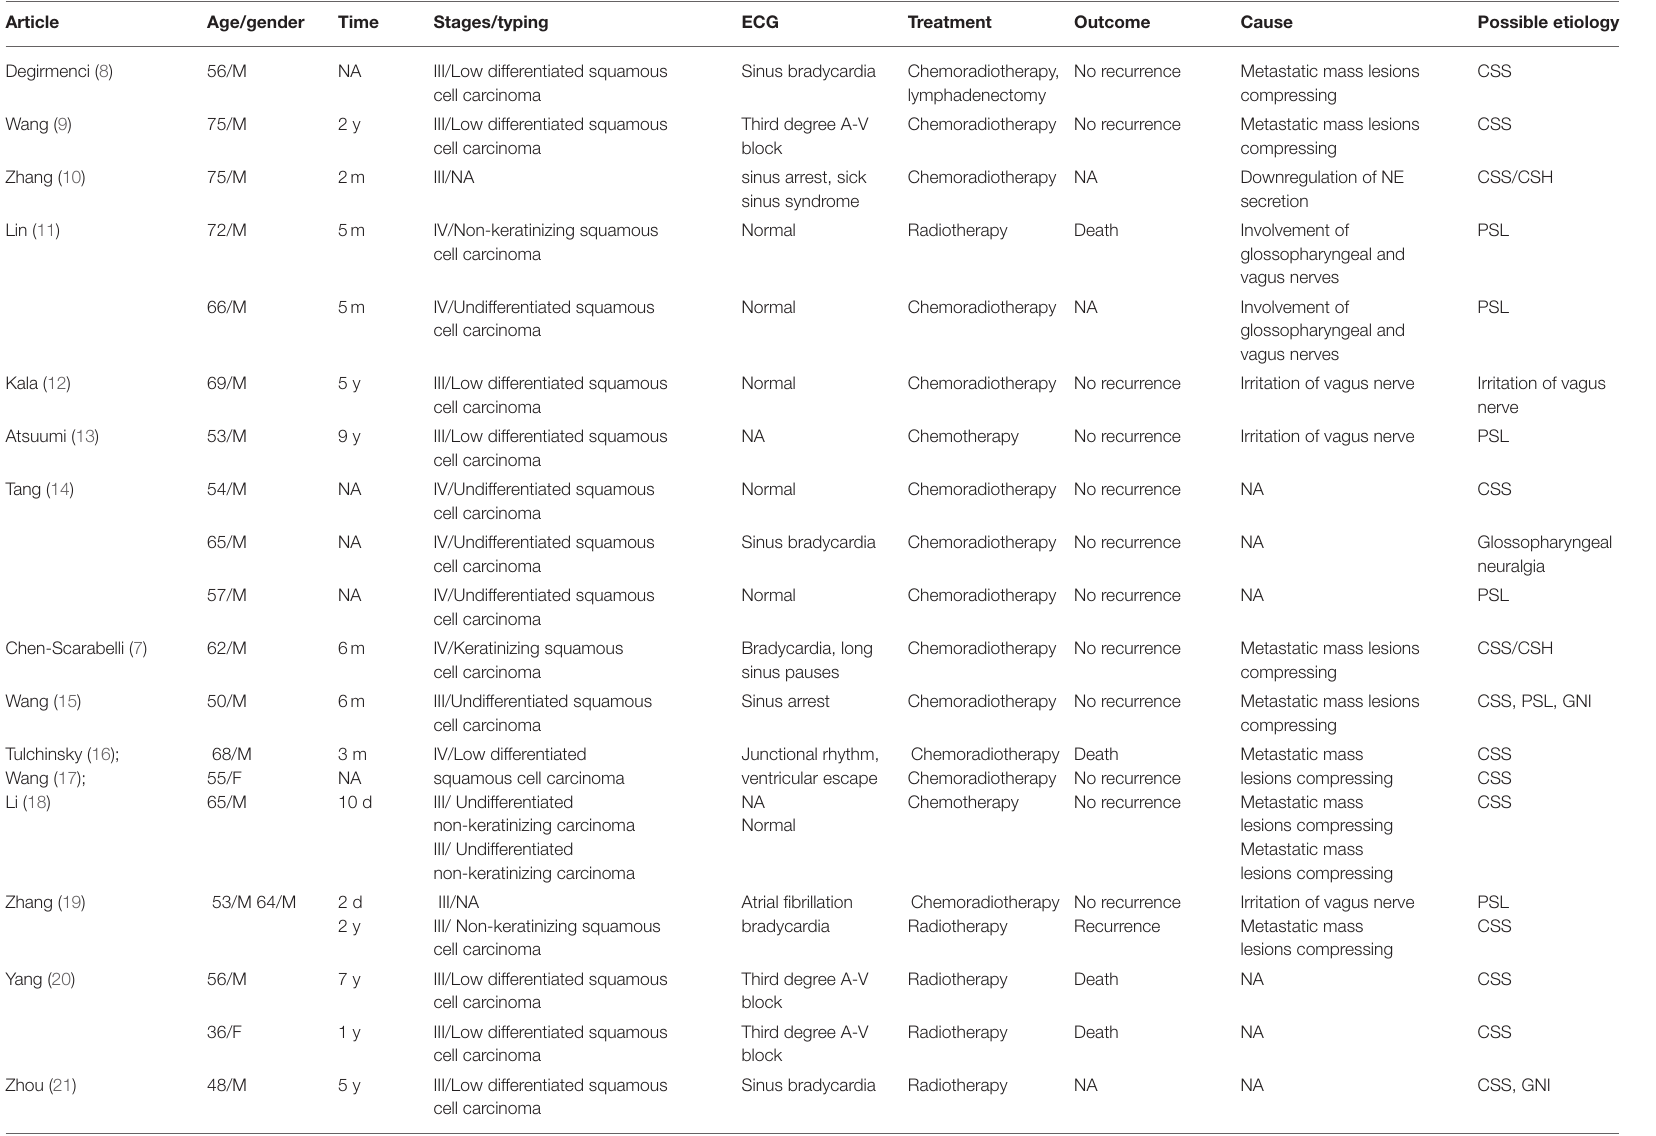
TABLE 1 | Summary of the cases of syncope associated with nasopharyngeal